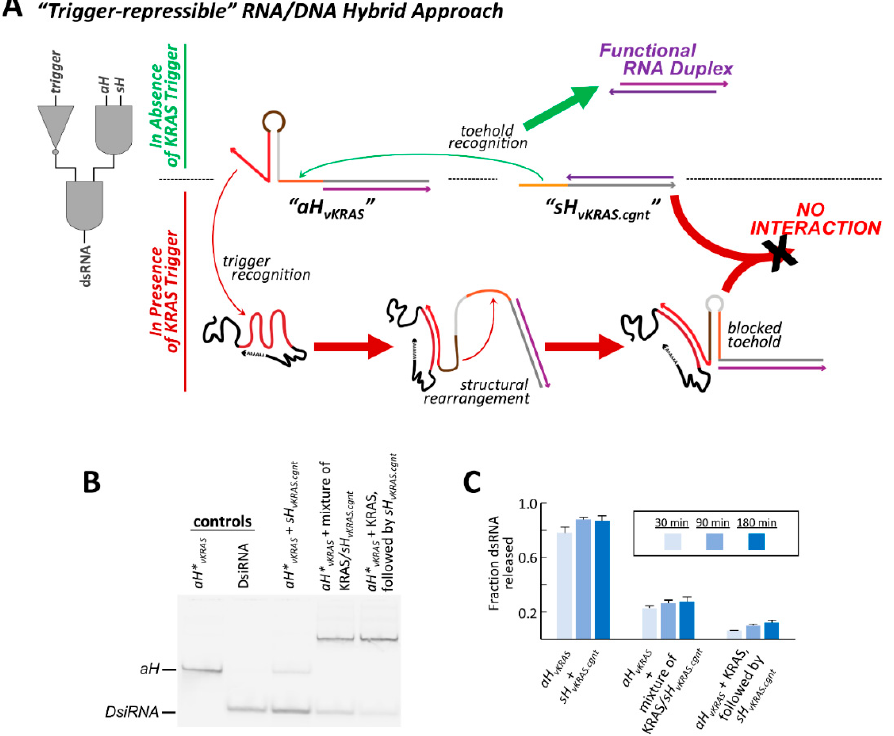
Figure 5. A redesign of the structured DNA responsive element allows for trigger-based conditional repression of dsRNA release. ( A ) A trigger-repressive hybrid system can be designed by combining a 2-input AND gate with a NOT gate. The antisense hybrid, aH ∨ KRAS , is designed to repress strand exchange in the presence of a trigger sequence derived from the Kirsten rat sarcoma proto-oncogene (KRAS) mRNA. If the trigger is absent, the exchange toehold of aH ∨ KRAS (sequence region colored orange) is freely accessible and can promote dsRNA release. If the trigger is present, its hybridization to the diagnostic toehold of aH ∨ KRAS (sequence region colored red) results in a structural rearrangement that blocks access to the exchange toehold and prevents interaction with the cognate sense hybrid, sH ∨ KRAS-cgnt . ( B ) The conditional function of this repressible system was assessed by 10% acrylamide non-denaturing PAGE. DsiRNA release from the aH ∨ KRAS / sH ∨ KRAS-cgnt pair was examined in three contexts: in the absence of the KRAS trigger (middle lane), when sH ∨ KRAS-cgnt and the KRAS trigger are premixed and added simultaneously to aH ∨ KRAS (2nd lane from right) , or when aH ∨ KRAS and the KRAS trigger are preincubated for 5 min prior to sH ∨ KRAS-cgnt addition (right lane). The KRAS trigger was added in 3-fold excess in both cases. The depicted gel shows samples incubated for 180 min at 37 ◦ C once all components are present. ( C ) Analysis of the fraction of dsRNA released from the KRAS repressible system following 30, 90, or 180 min incubations at 37 ◦ C. Error bars indicate standard deviation of three replicate experiments. Indication of statistical significance between samples is reported in the supporting information.